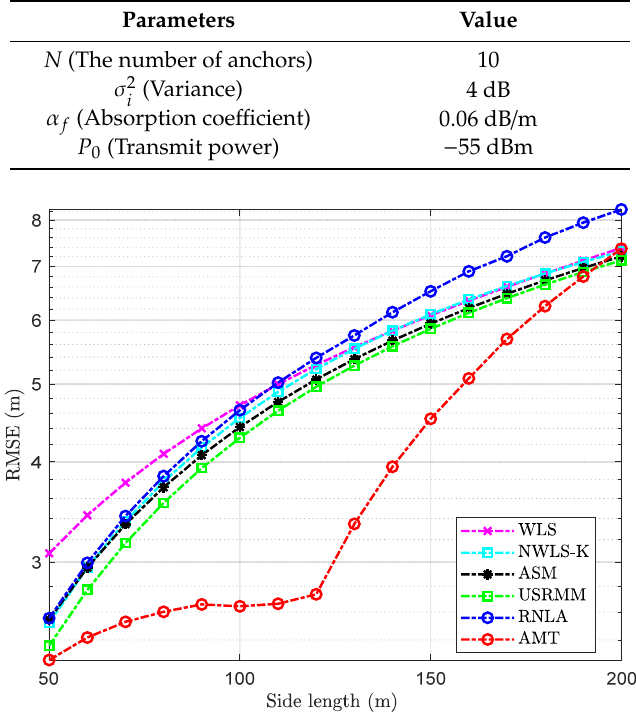
= 4 dB, α = 0.06 dB/m, and P =   , and   , 0.06 dB/m 0 f i f i